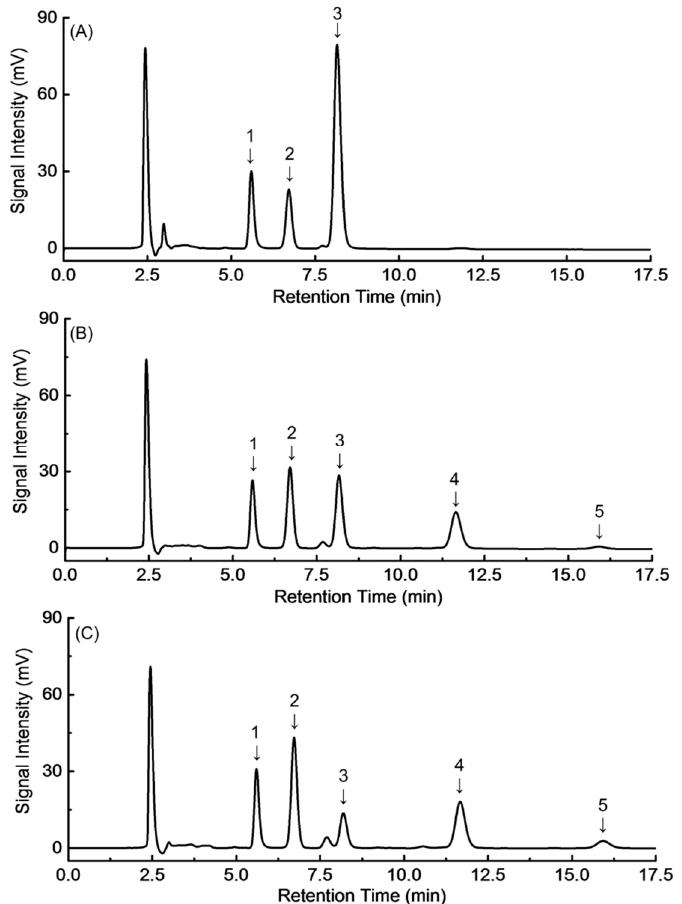
Figure 1. Representative high performance liquid chromatography (HPLC) profiles of fresh longan juice ( A ) and enzyme treated longan juices for 2 h ( B ), and 5 h ( C ). Identified peaks are as follows: 1, fructose; 2, glucose; 3, sucrose; 4, 1-kestose; 5, nystose.